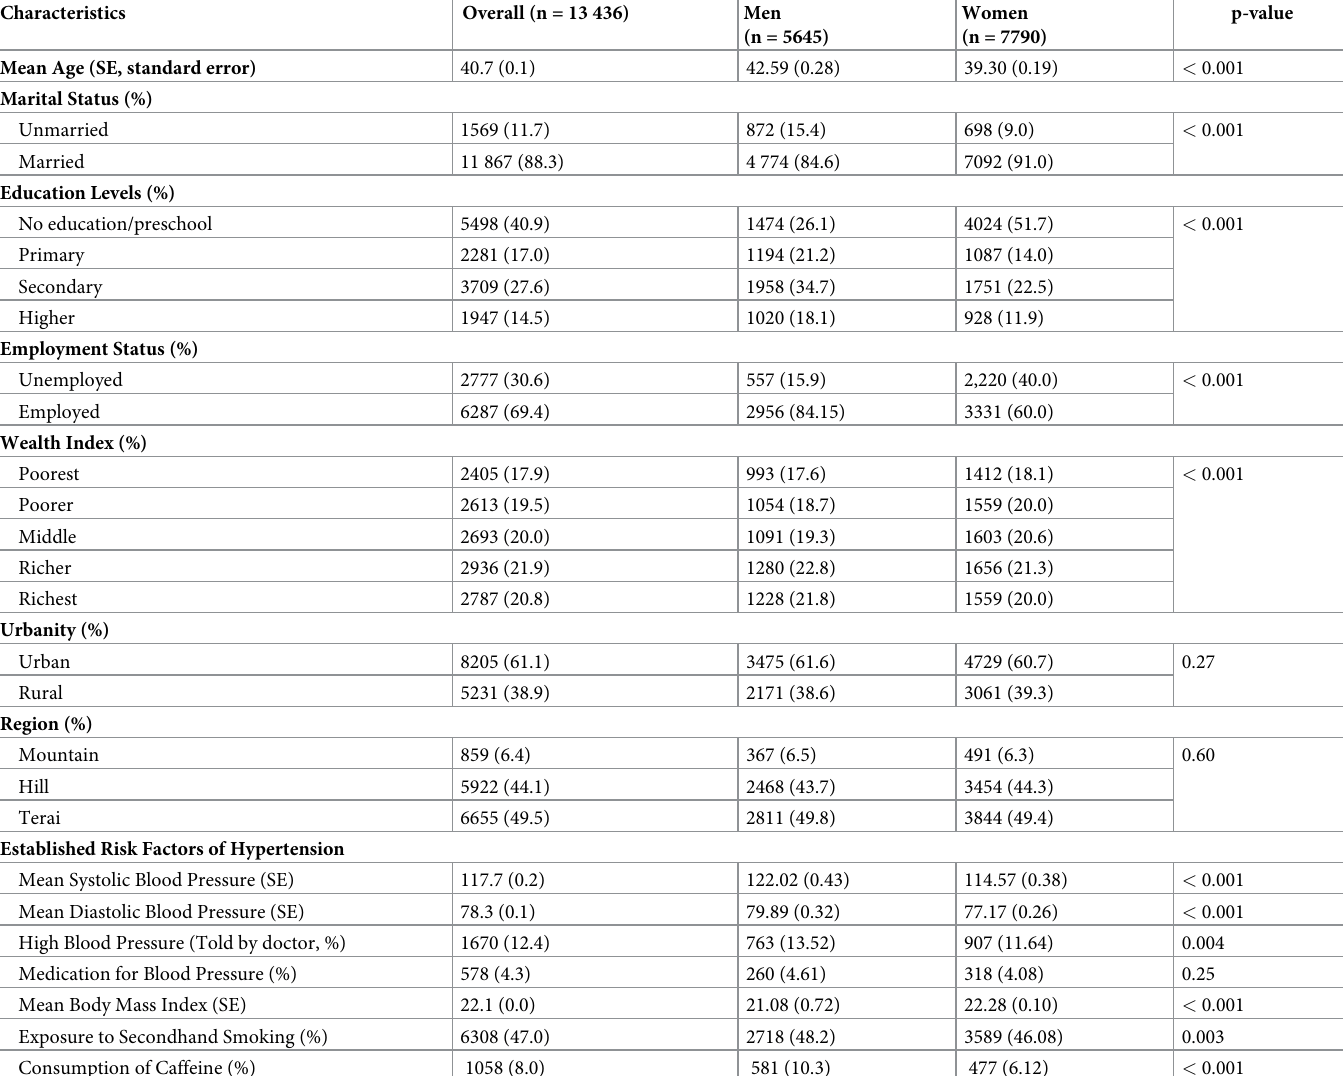
Table 2. Sample characteristics (weighted numbers and percentages unless stated